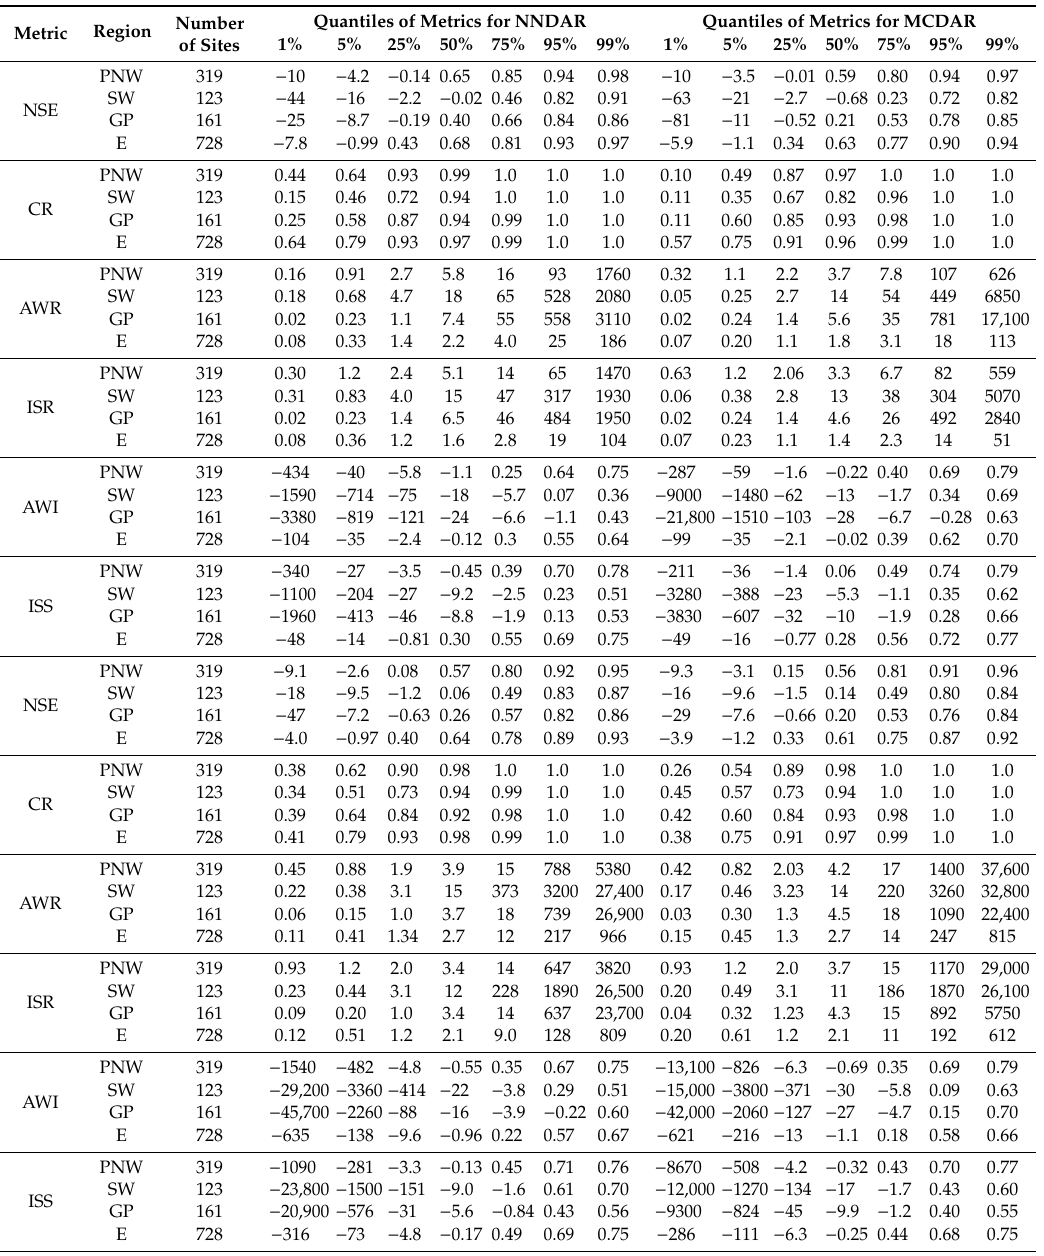
Table 1. Quantiles of performance metrics for simulation and uncertainty intervals of daily streamflow four simulation methods in four regions: Pacific Northwest and mountains (PNW), Southwest (SW), Great Plains (GP), and Eastern U.S. (E). Simulation methods include drainage area ratio using nearest neighbor index gage selection (NNDAR) and map correlation selection methods (MCDAR) and nonlinear spatial interpolation using flow duration curves (QPPQ) using nearest neighbor index gage selection (NNQPPQ) and map correlation index gage selection